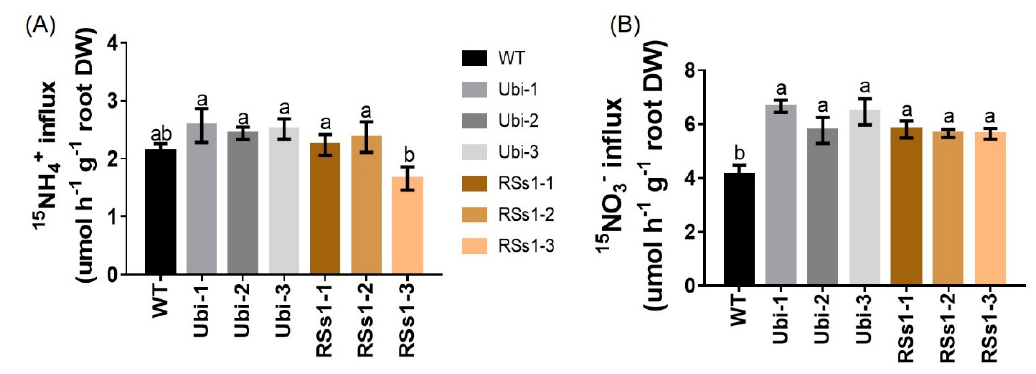
Figure 6. NH 4 + and NO 3 − influx rates of WT and transgenic plants measured using 15 N-enriched Figure 6. NH 4+ and NO 3 ‐ influx rates of WT and transgenic plants measured using 15 N ‐ enriched sources. WT and transgenic barley seedlings were grown in 1 / 4 Hoagland nutrient solution for 2 weeks sources. WT and transgenic barley seedlings were grown in 1/4 Hoagland nutrient solution for 2 and N starved for 4 days. Then, NO 3 − and NH 4 + influx rates were measured at ( A ) 0.2 mM 15 NH 4 + weeks and N starved for 4 days. Then, NO 3– and NH 4+ influx rates were measured at ( A ) 0.2 mM ( B ) 0.2 mM 15 NO 3 − for 5 min. Di ff erent letters indicate a significant di ff erence between transgenic and 15 NH 4+ ( B ) 0.2 mM 15 NO 3 ‐ for 5 min. Different letters indicate a significant difference between WT lines ( p < 0.05, one-way ANOVA). Error bars: standard error ( n = 4 transgenic and WT lines ( p < 0.05, one ‐ way ANOVA). Error bars: standard error ( n = 4 plants).